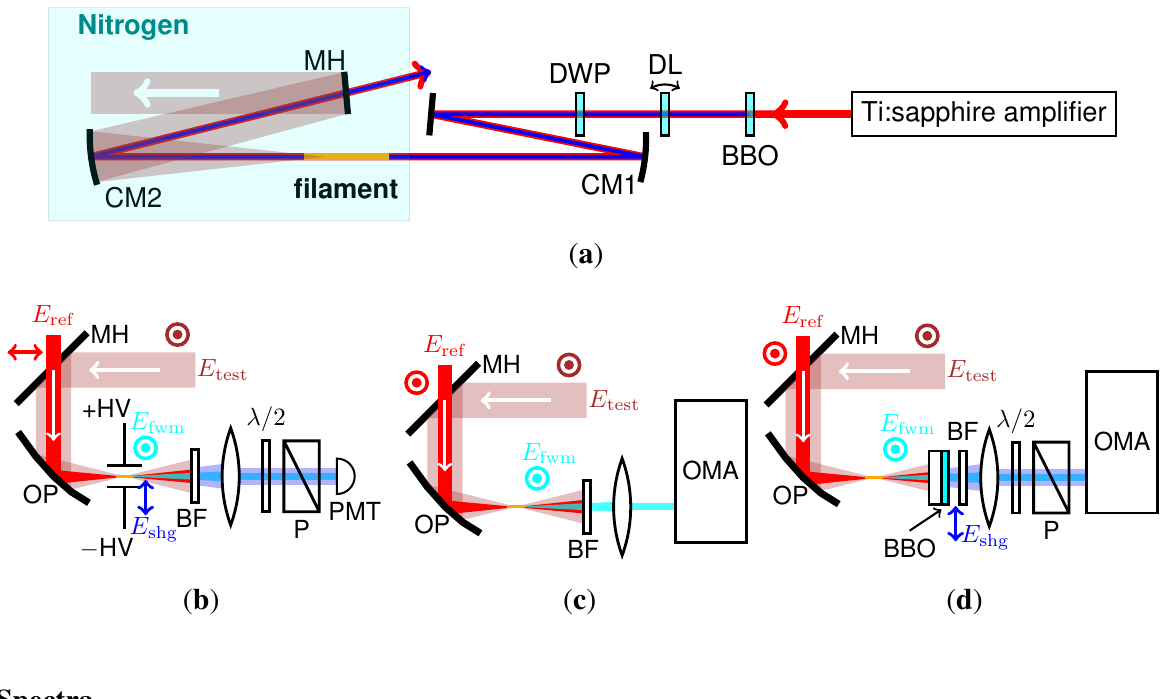
Figure 1. ( a ) Schematic of the system. Shaded region was purged with nitrogen at around atmospheric pressure. BBO: β -BaB θ = 29 ◦ , t = 100 µ m), DL: delay plate (calcite crystal, t = 1 . 7 mm), DWP: dual wave plate ( λ at 400 nm, λ/ 2 at 800 nm), CM1: r = 1 m concave mirror, CM2: r = 0 . 5 m concave mirror, MH: aluminium-coated mirror with a hole ( φ = 7 mm); ( b ) Schematic of the system for electro-optic sampling. OP: aluminium-coated off-axis parabolic mirror, BF: bandpass filter for 400 nm (10 nm FWHM, FB400-10, Thorlabs), P: calcite polarizer, PMT: photomultiplier tube (H10721-210, Hamamatsu); ( c ) Schematic of the system for cross-correlation frequency-resolved optical gating. BF: bandpass filter for 335–610 nm (FGB37, Thorlabs), OMA: spectrometer for ultraviolet region (USB2000+, OceanOptics); ( d ) Schematic of the system for carrier-envelope phase measurement. BBO: β -BaB crystal (Type I, θ = 29 ◦ , t = 50 µ m) on a fused silica substrate ( t = 2 mm), BF: bandpass filter for 335–610 nm (FGB37, Thorlabs), P: calcite polarizer, OMA: spectrometer for ultraviolet region (USB2000+,